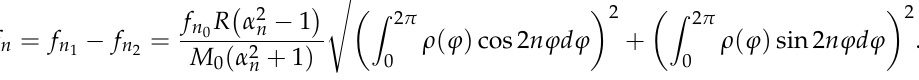
Figure 2. Schematic diagram of resonator vibration. AA, BB are the two eigenaxes. fn 1 , fn 2 are the natural frequency of the resonator.